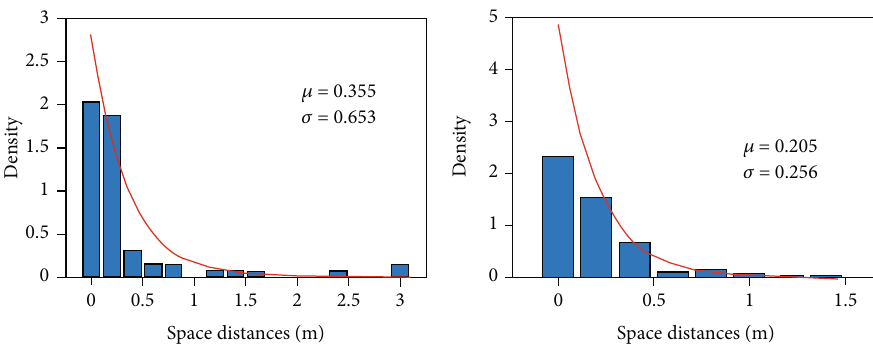
Figure 10: Histogram of space distance distribution of two groups of the rock mass structure plane.